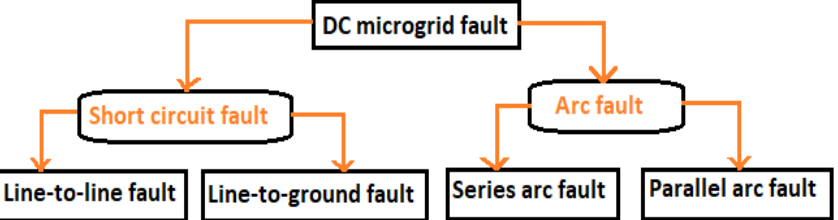
Figure 2. Possible fault types in the DCMG system.